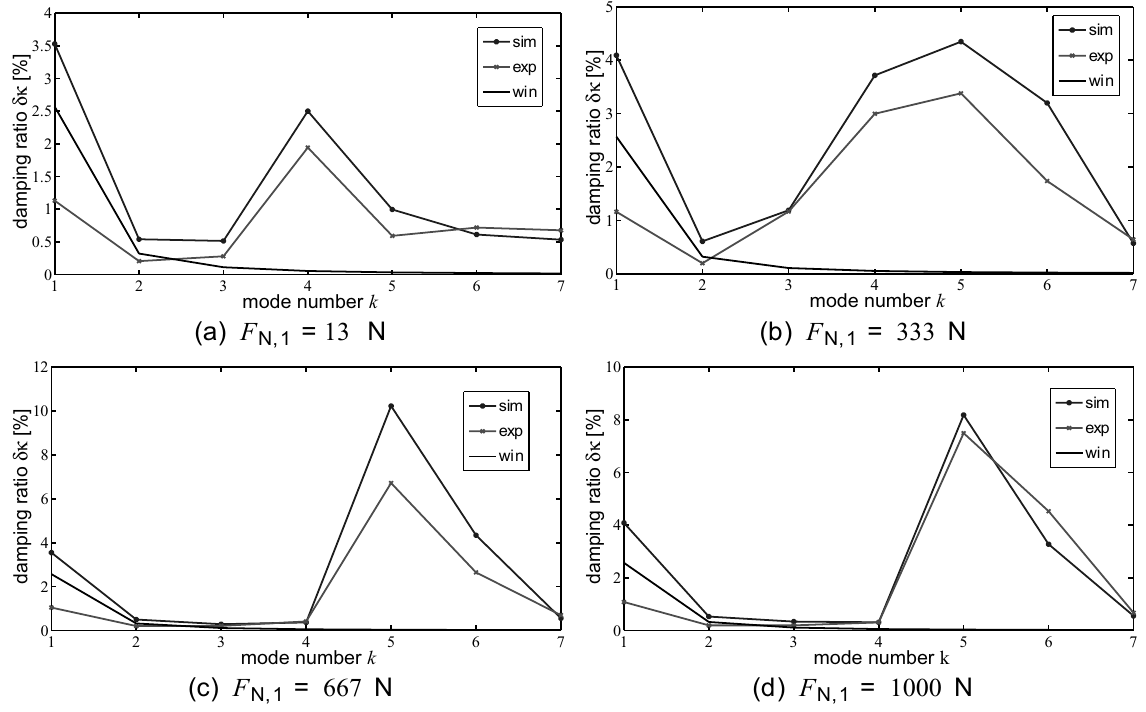
Fig. 12. Modal damping ratios δ k from simulation and experiment (artificial window damping shown for information). For the simulations, experimentallymeasured impulses are averagedand applied as loads. As in the measurements, FRFs are calculated from the 6 s responses using an exponential window of time constant τ = 2 s.